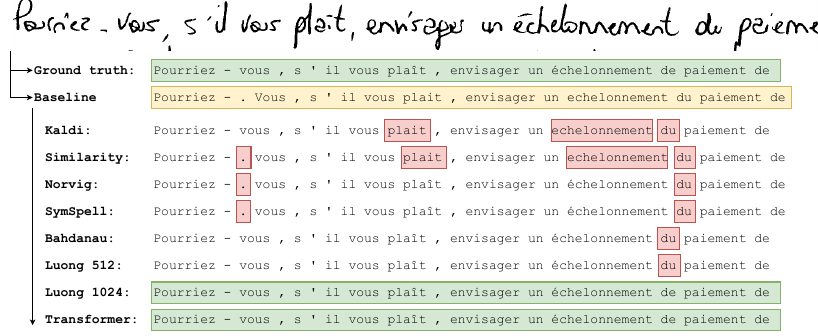
Figure 17. Correction sample in the RIMES